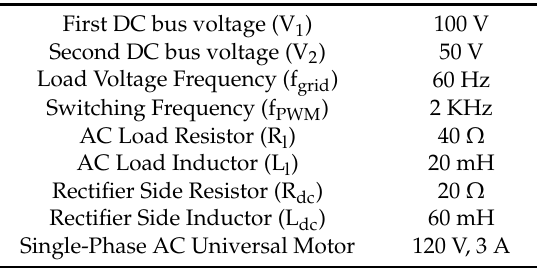
Table 2. Experimental setup parameters.